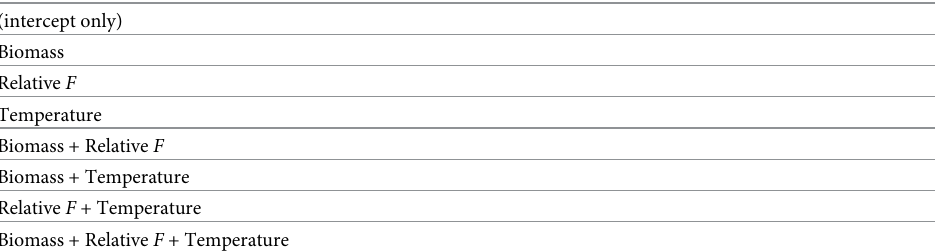
Table 3. The set of models used to sum Akaike